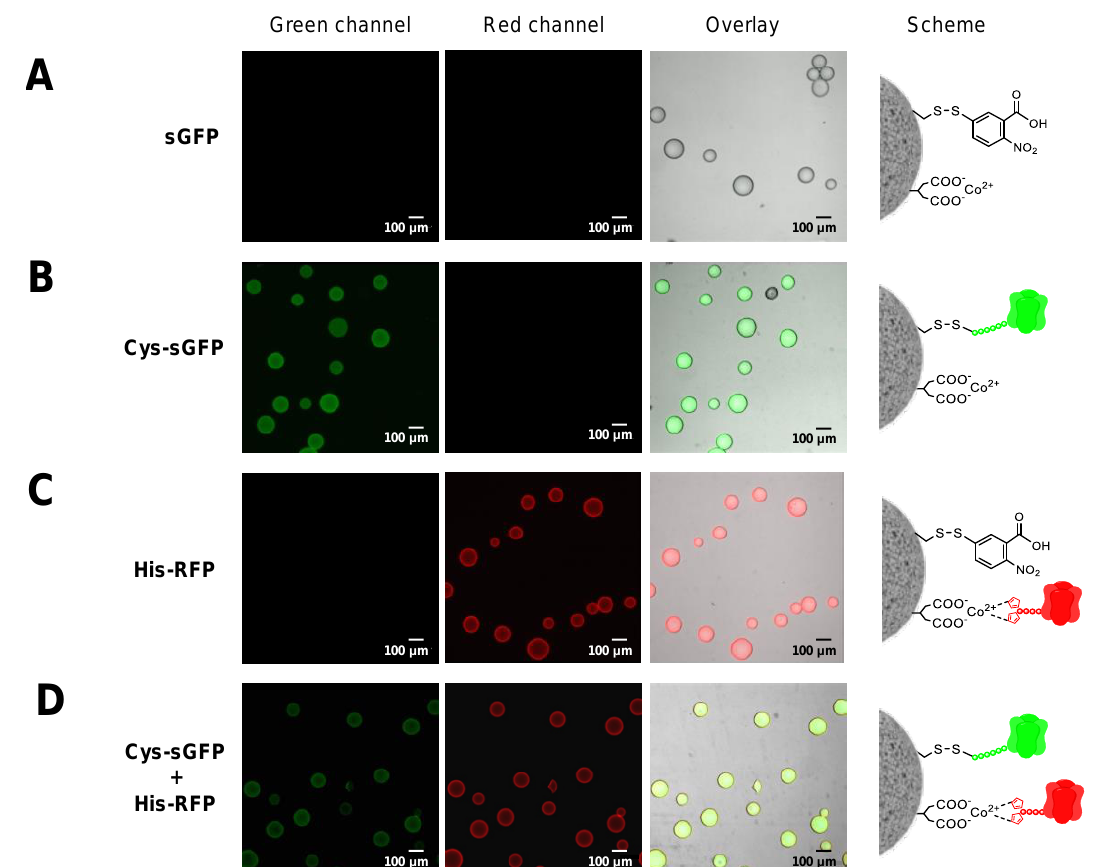
Figure 5. CLSM imaging of the tag-driven selective co-immobilization of FPs on AG-Co 2 + / S. ( A ) Untagged sGFP was incubated with AG-Co 2 + / S, but no immobilization was detected. ( B ) Cys-sGFP immobilized on AG-Co 2 + / S by reversible disulfide bonds. ( C ) His-RFP immobilized on AG-Co 2 + / S by metal coordination bonds. ( D ) Cys-sGFP and His-RFP co-immobilized on AG-Co 2 + / S. From left to right: green channel ( λ ex : 488 nm, λ em : filter LP505 nm), red channel ( λ ex : 561 nm, λ em : filter LP565 nm), overlay of fluorescence and brightfield signals, and the scheme of the protein immobilization.